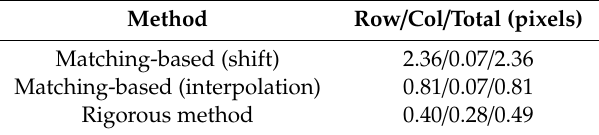
Figure 13. Extracted key points ( a ) PAN, ( b ) MS. Table 10. Co-registration root mean square error (RMSE) for the check points.